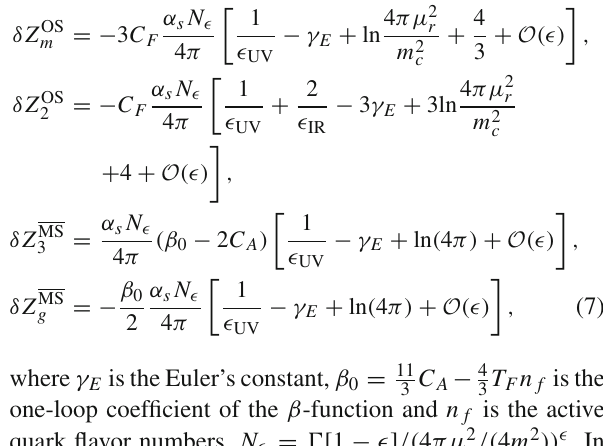
Table 1 Total cross sections for e + e − → J /ψ + χ cJ (in unit: fb), with J = 0 , 1 , 2. m c = 1 . 5 GeV. J /ψ + χ